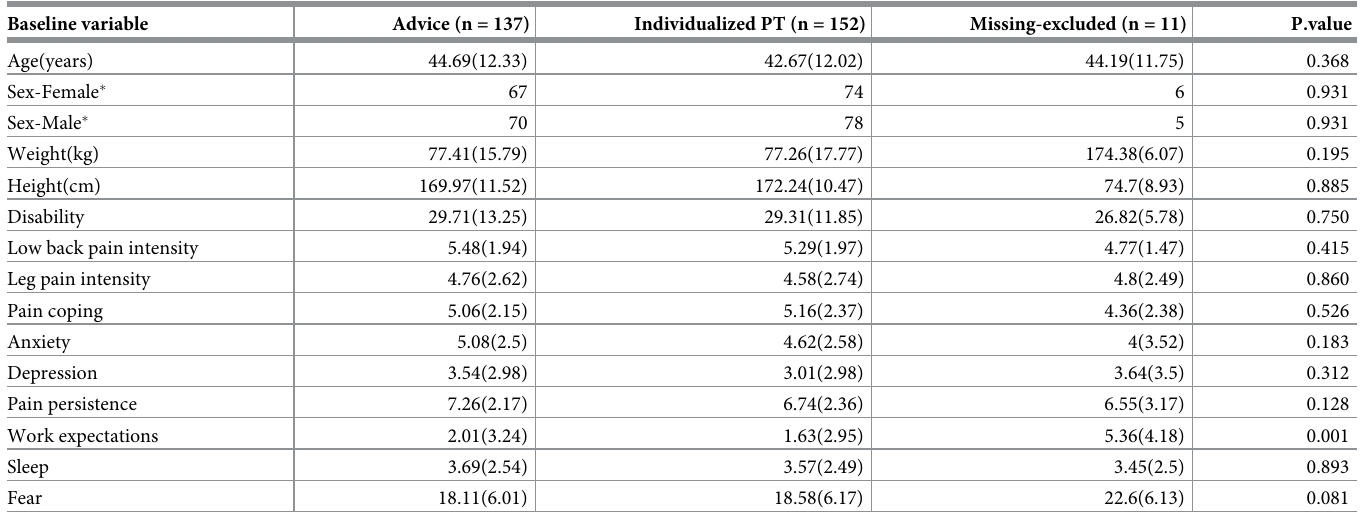
Table 1. Baseline descriptive characteristics of cohort included in Bayesian Network